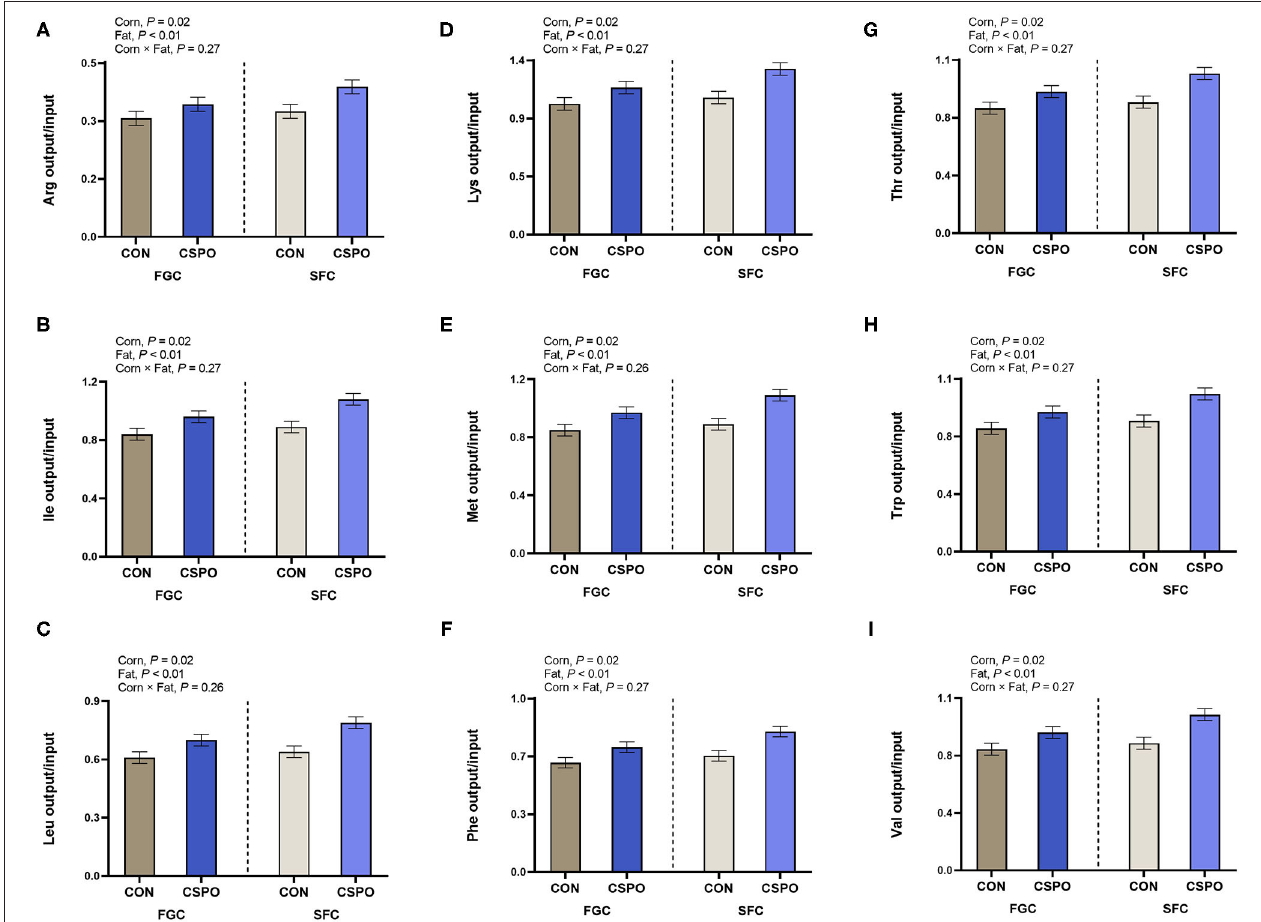
FIGURE 3 | Milk recovery of indispensable amino acids (A–I) in cows that grazed elephant grass and received treatments as a concentrate supplement. The concentrate contained either fine ground corn (FGC) or steam-flaked (SFC) corn associated or not with supply of Ca salts of palm fatty acids (not supplemented—CON or